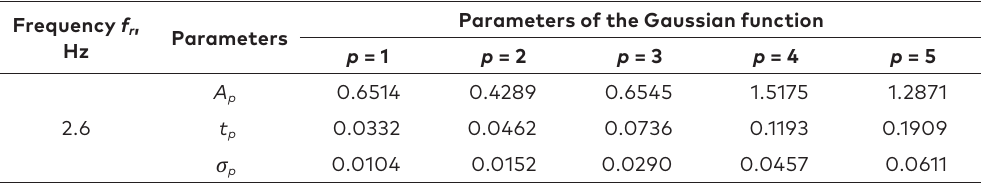
Table 5. Parameters of the template for running frequency of 2.6 Hz